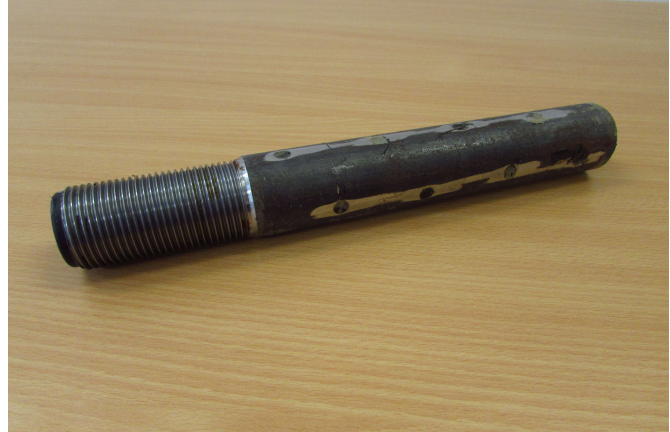
Figure 5. Anchor for a cyclic test of bare